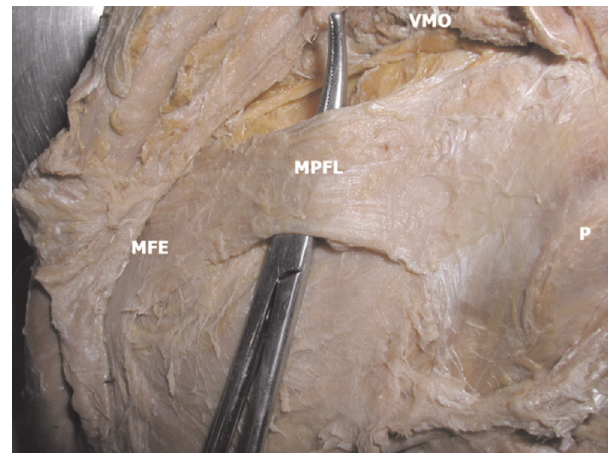
Figure 1 - The medial patellofemoral ligament. MPFL - medial patel- lofemoral ligament; VMO - vastus medialis obliquus; MFE - medial femoral epicondyle; P – patella